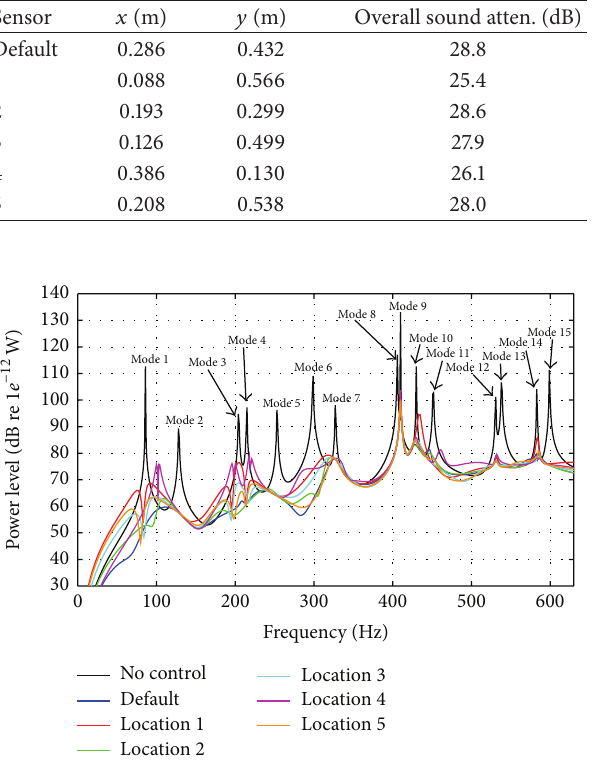
Figure 12: Simulated control of the clamped plate at multiple sensor